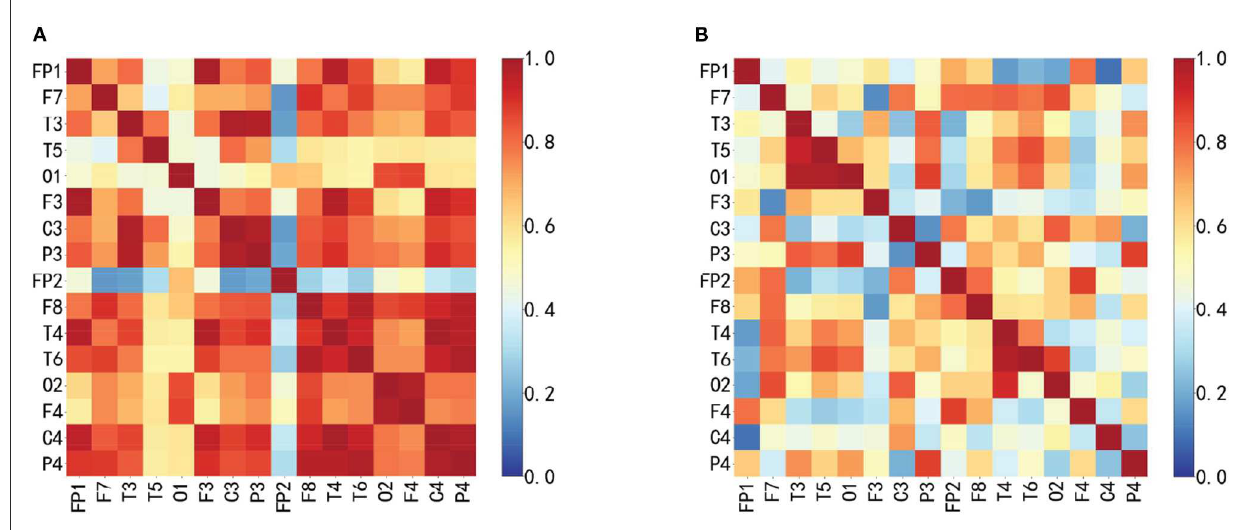
FIGURE4 Functional brain network association matrix, horizontal axis and vertical axis represent EEG lead combination, the element value in the matrix is the PLV between any two node signals, the PLV range is [0,1], blue represents the PLV is small, red represents the PLV is large. (A) Spike discharge. (B) Nospike discharge.